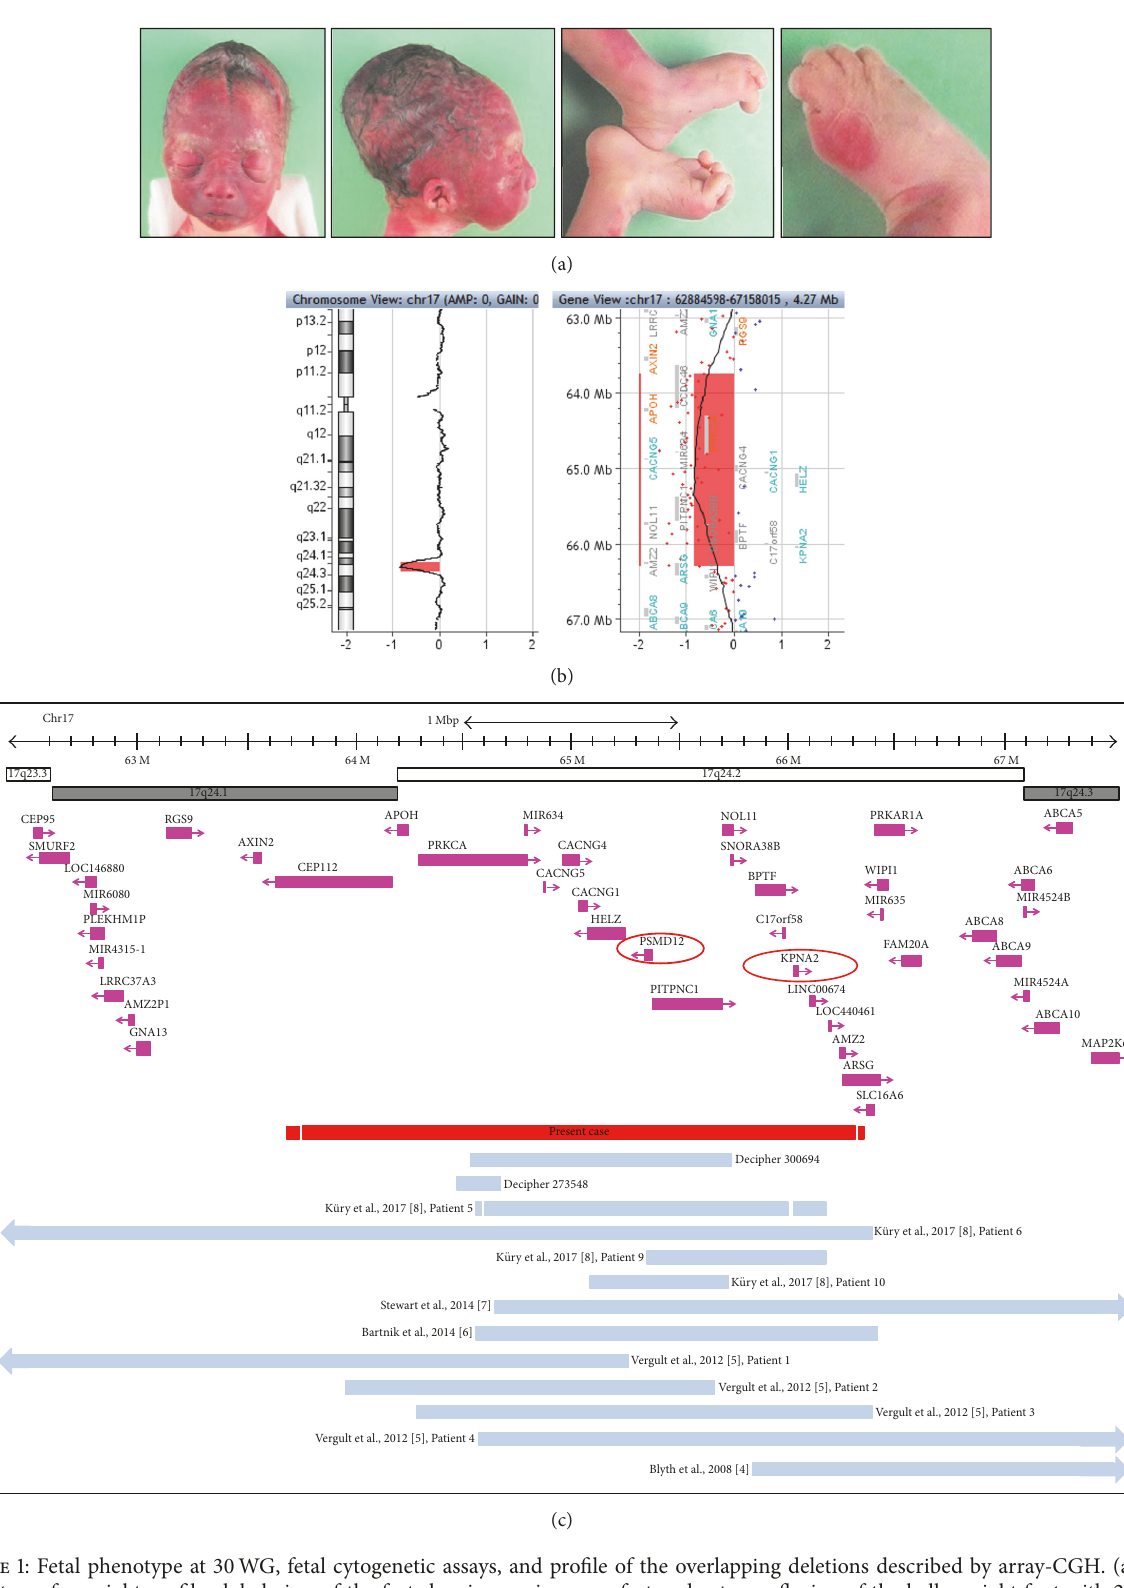
Figure 1: Fetal phenotype at 30 WG, fetal cytogenetic assays, and profile of the overlapping deletions described by array-CGH. (a) Fetal phenotype: face; right profile global view of the feet showing equinovarus feet and extreme flexion of the hallux; right foot with 2-3 toes’ cutaneous syndactyly. (b) Agilent PreCytoNem 105K array-CGH profile of chromosome 17 showing a 2.5 Mb 17q24.1q24.2 deletion. (c) Profile of the overlapping deletions described by array-CGH (patients of Blyth et al. and Stewart et al. were remapped in